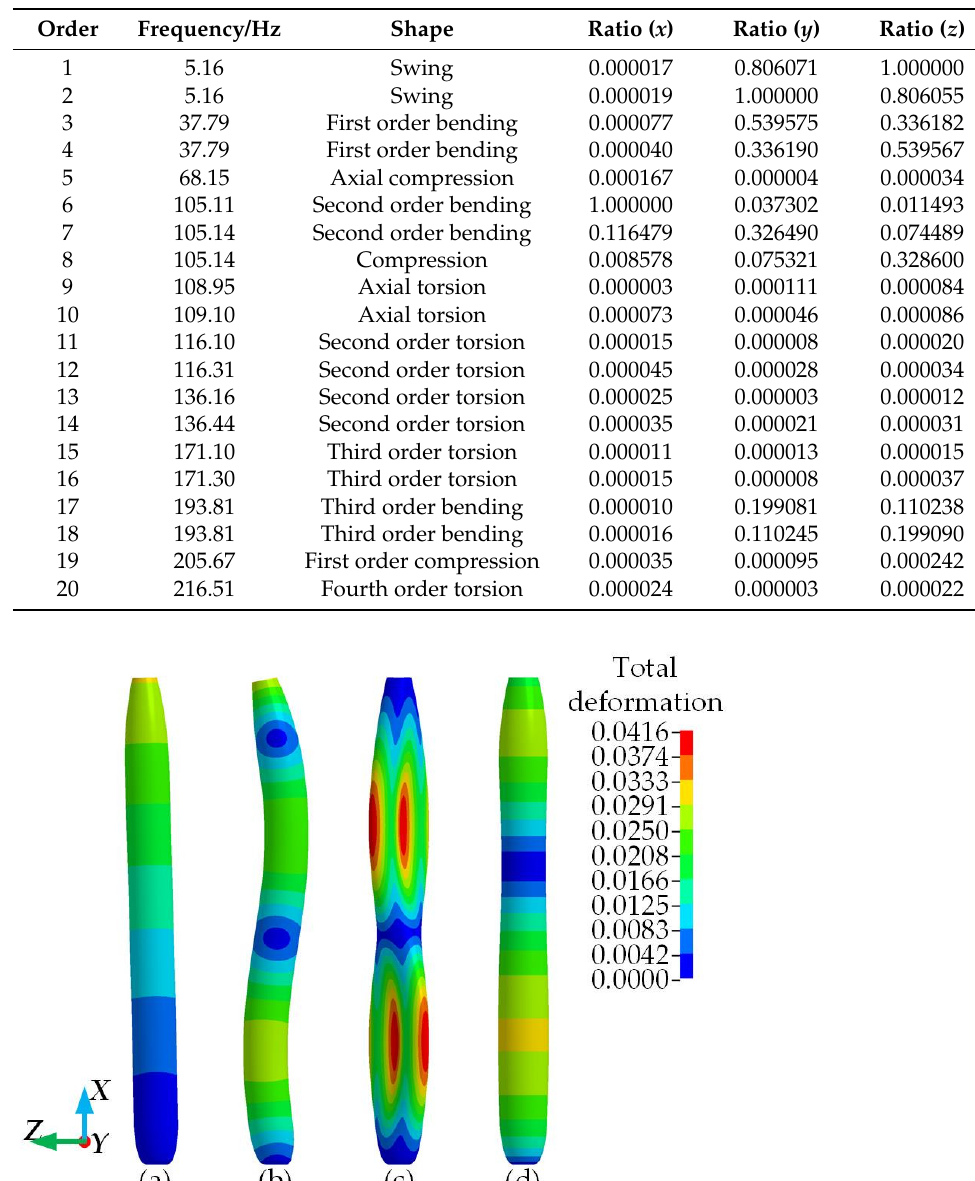
Table 10. Natural frequency of vehicle.